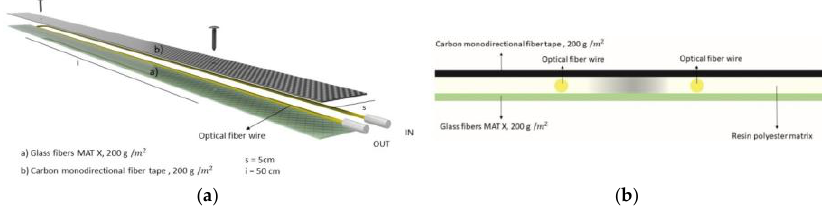
Figure 2. CG Transducer ( a ) axonometric view, ( b ) cross-section.